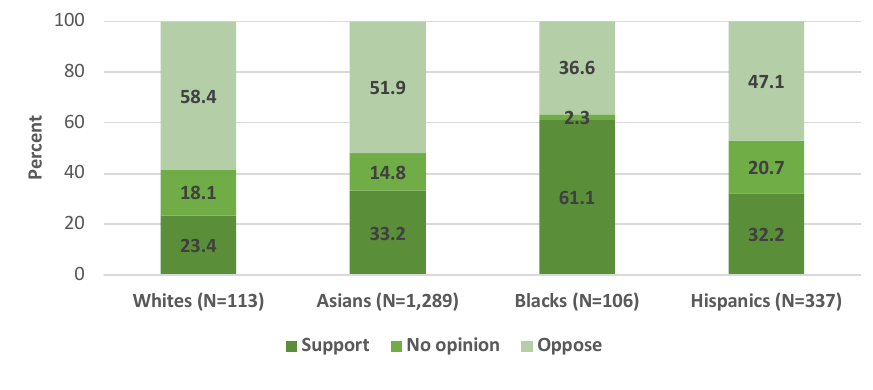
Figure 1: Attitudes on preferential hiring and promotion by frame and race. All figures are weighted percent- ages. Source: 2016 National Asian American